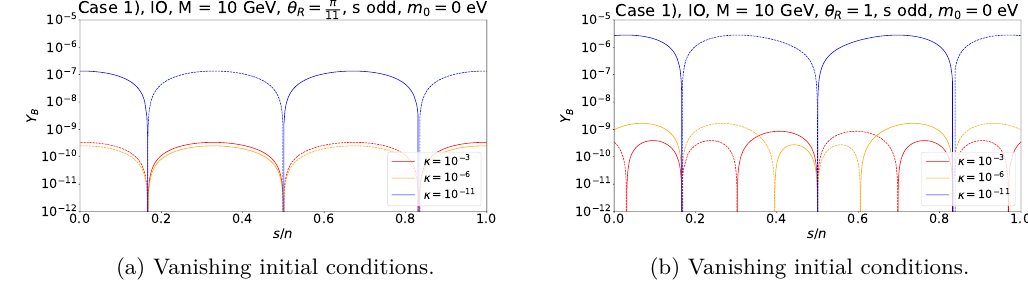
, treated as continuous parameter, for a Majorana Figure 28 . Case 1) Y B as function of s n mass M = 10 GeV and for θ = π (left plot) and θ = 1 (right plot). The light neutrino R R 11 mass spectrum follows strong IO. The parameter s is assumed to be odd. Different values of κ , κ ∈ { 10 − 3 , 10 − 6 , 10 − 11 } , are considered. Both negative (dashed lines) as well as positive (continuous lines) values of the BAU are